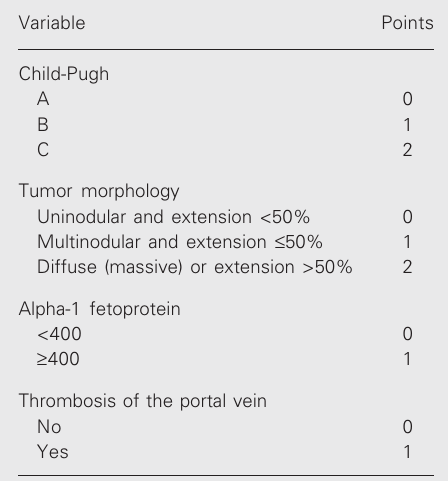
Table 6. Cancer of the Liver Italian Program (CLIP) classification of hepatocellular carcinomas (17).